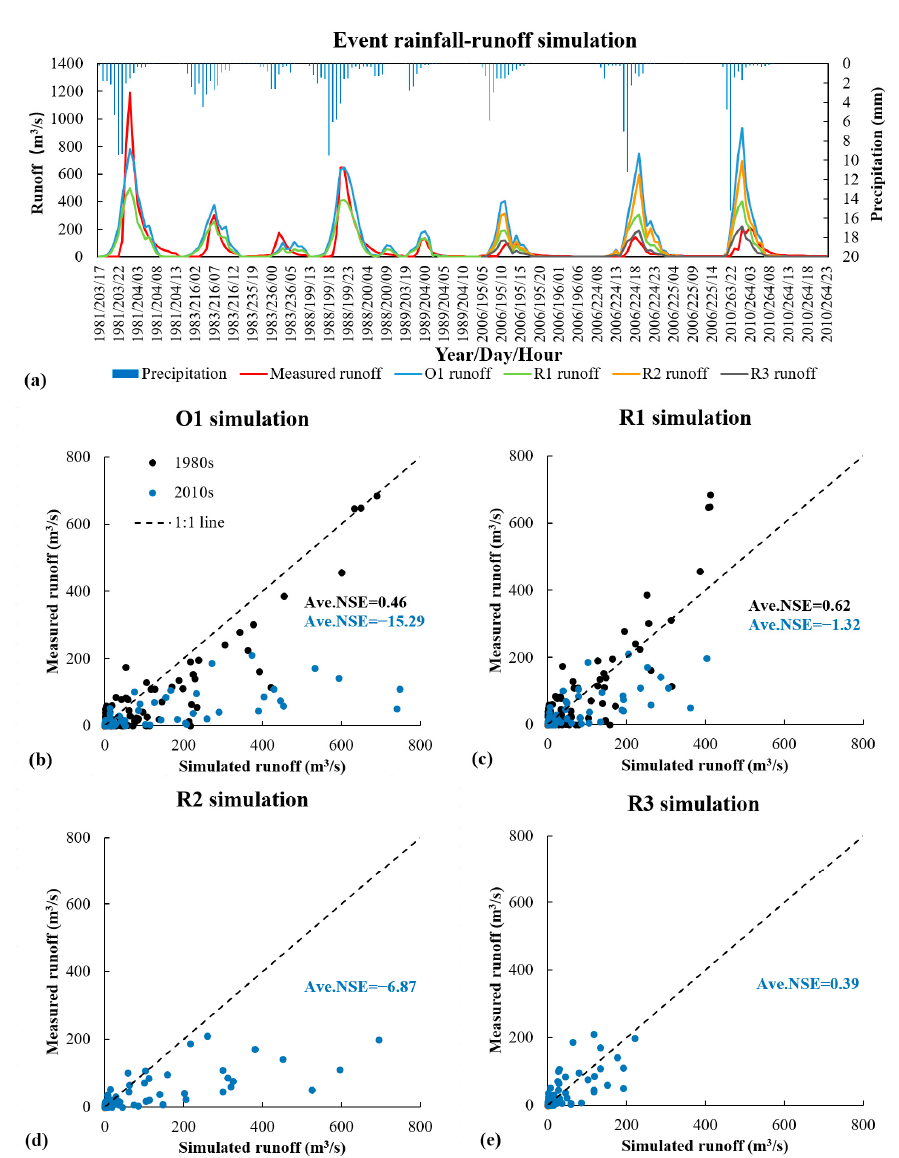
Figure 7. Comparison of observed and simulated runoff for eight events in the Pianguanhe Basin. ( a ) ( a ) Event rainfall-runo ff simulation; ( b ) Runo ff in O1 simulation; ( c ) Runo ff in R1 simulation; ( d ) Runo ff Event rainfall-runoff simulation; ( b ) Runoff in O1 simulation; ( c ) Runoff in R1 simulation; ( d ) Runoff in R2 simulation; ( e ) Runo ff in R3 in R2 simulation; ( e ) Runoff in R3 simulation.